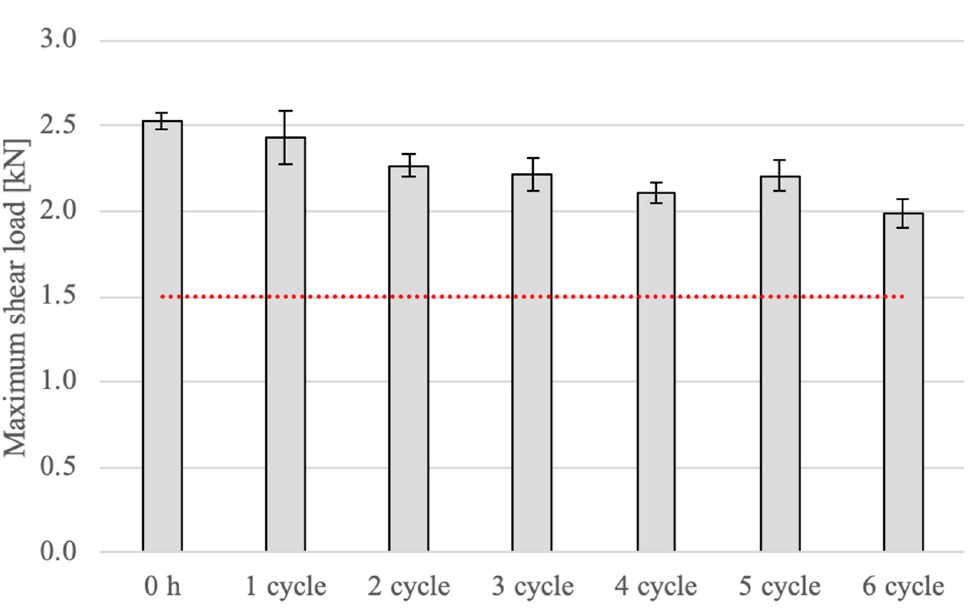
Figure 17. Maximum shear strength of RJS specimens immersed in an ultrasound mixture following a cyclic pattern. The red dotted line represents the threshold value for the RJS specimen’s minimum allowed joint strength (1.5 kN).